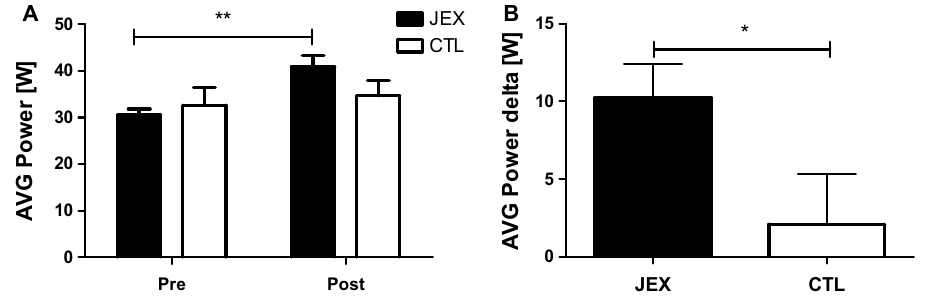
Figure 3. The effect of JEX on AVG power ( A ), and the contrast between the JEX delta (post–pre) and the CTL delta (post–pre) ( B ). The values represent the mean. The error bars indicate the standard error of the mean.